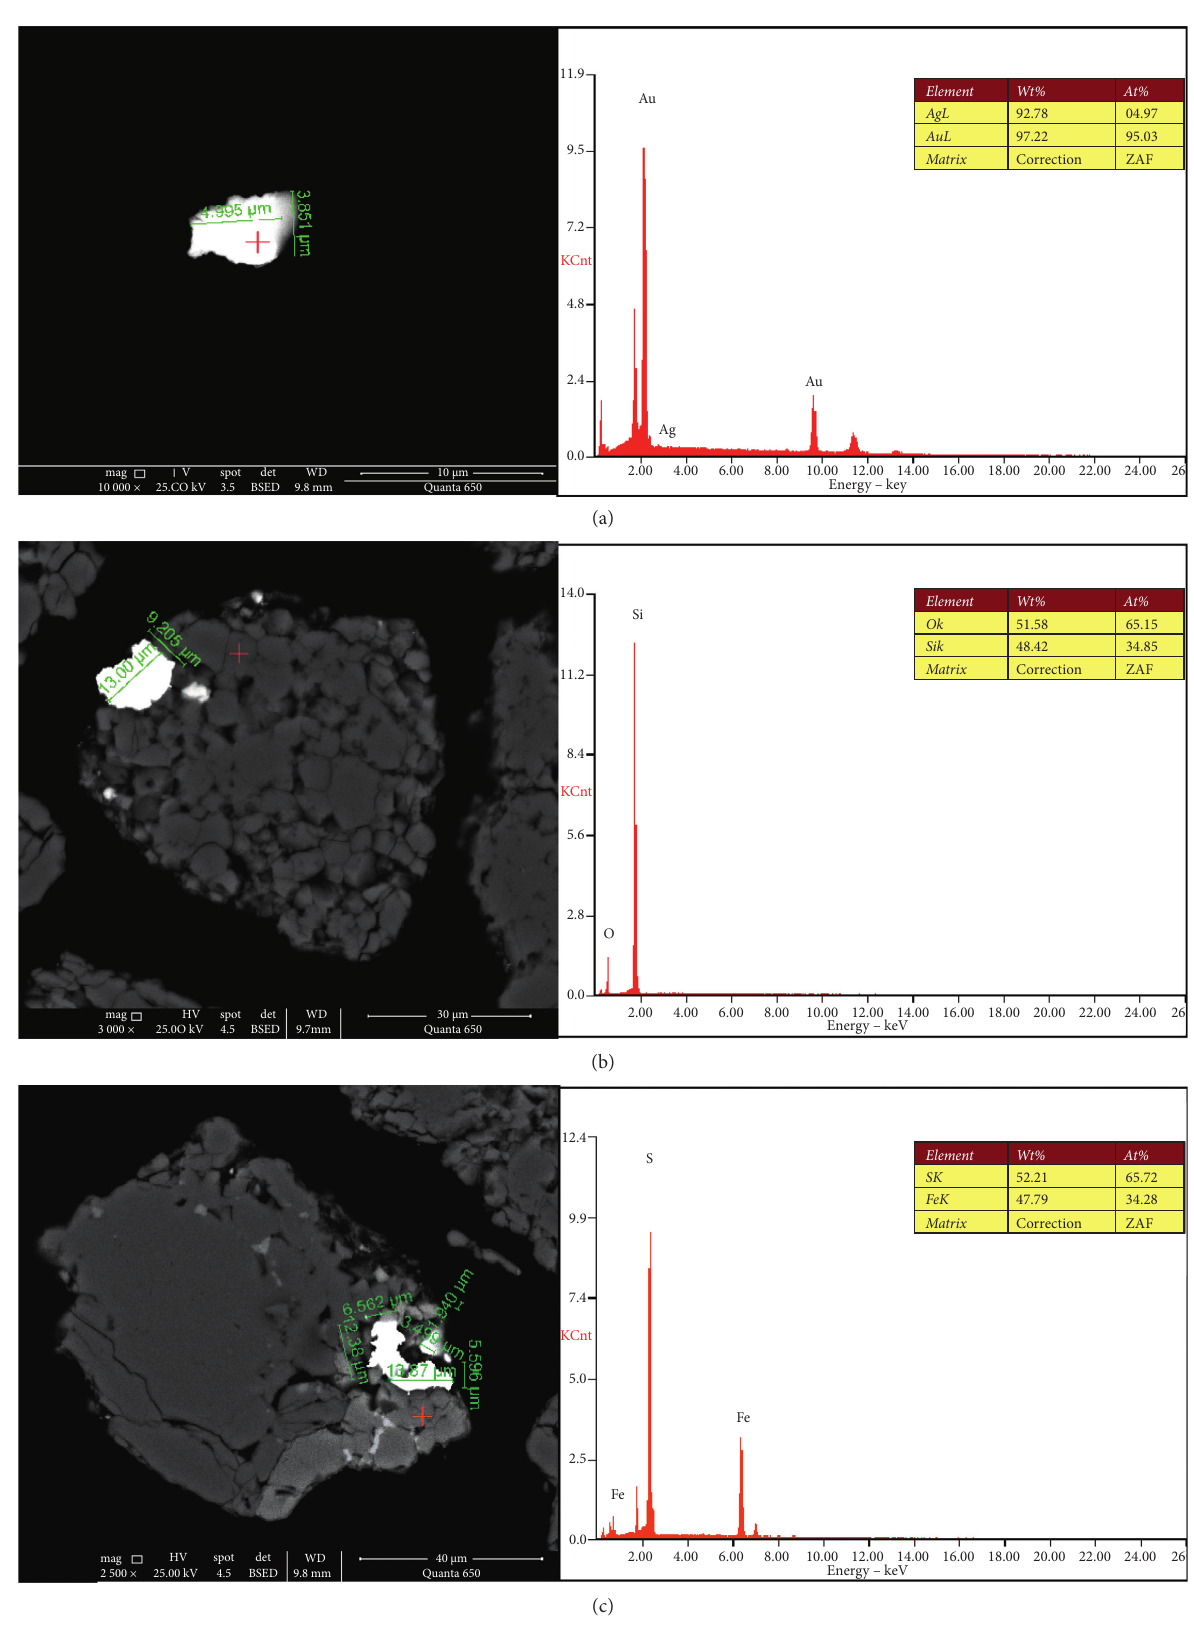
Figure 2: Gold phase images of the raw sample. (a) Native gold in a single form. (b) Native gold locked by quartz. (c) Native gold intergrown with